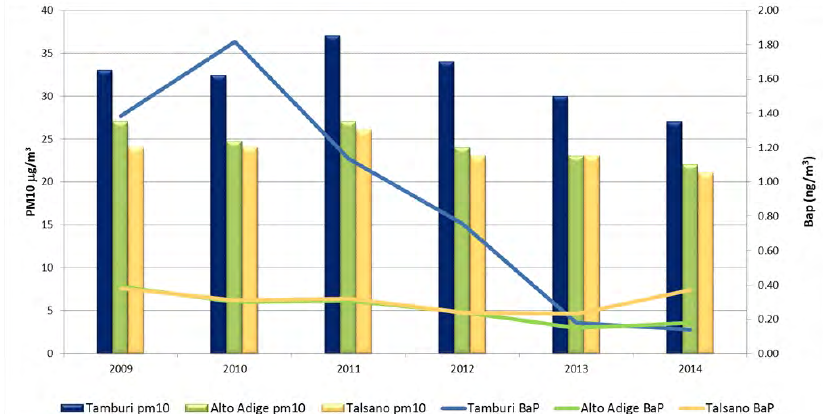
Fig. 4: PM10 and benzo(a)pyrene annual mean trend from 2009 to 2014.